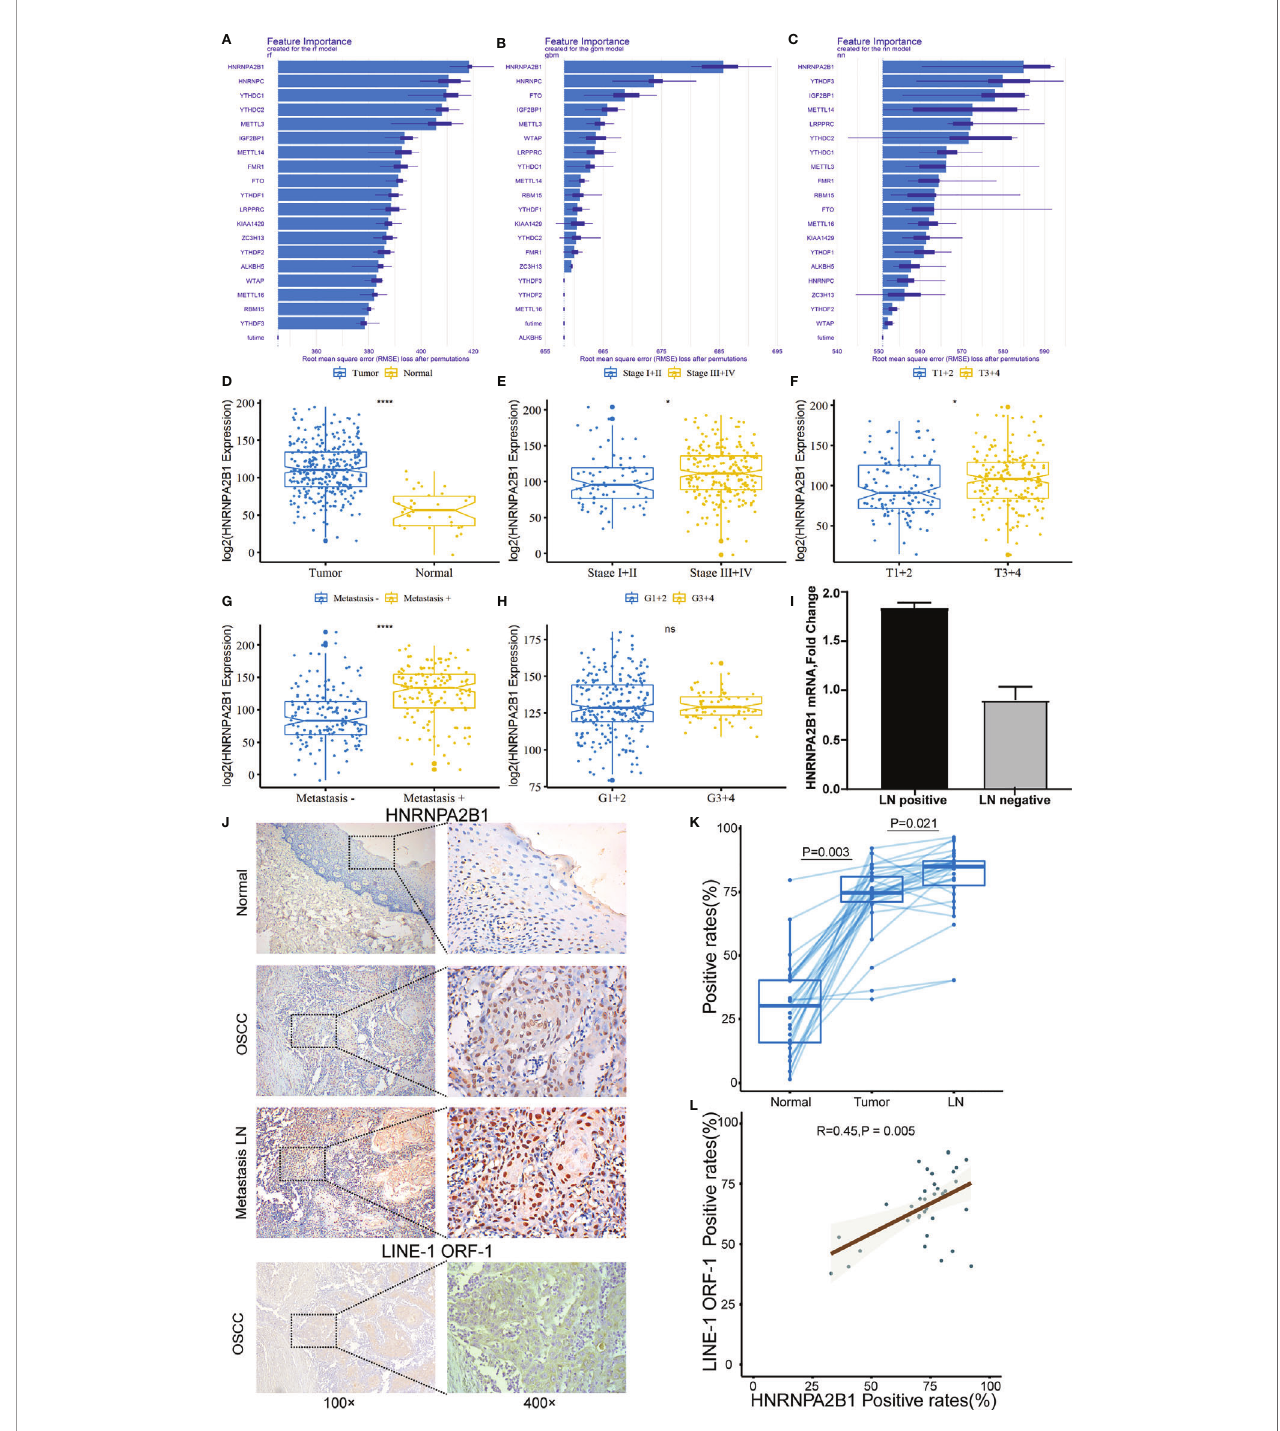
FIGURE 4 | The correlation between HNRNPA2B1 and clinicopathologic parameters of OSCC. (A – C) Rank chart for the 19 m 6 A regulatory genes by neural network, random forest (rf), and gradient boosting machine (gbm). (D) HNRNPA2B1 expression is higher in tumor tissues compared with normal tissues. High HNRNPA2B1 expression was signi fi cantly associated with (E) tumor stage, (F) T categories, and (G) metastasis. (H) HNRNPA2B1 expression was not associated with histological grade (p > 0.05). (I) The mRNA expression of HNRNPA2B1 in patients with or without lymph node metastasis was detected by RT-PCR. (J) Representative images of immunohistochemical staining and (K) quanti fi cation of HNRNPA2B1 in human normal mucosa, OSCC tissue, and metastasis LN. Metastasis means at least one lymph node metastasis, local or distant metastasis. (L) LINE-1 expression is positively correlated with HNRNPA2B1 expression according to the analysis results of the IHC score. * and **** indicated p<0.05 and p<0.0001, respectively. “ ns ” indicates no signi fi